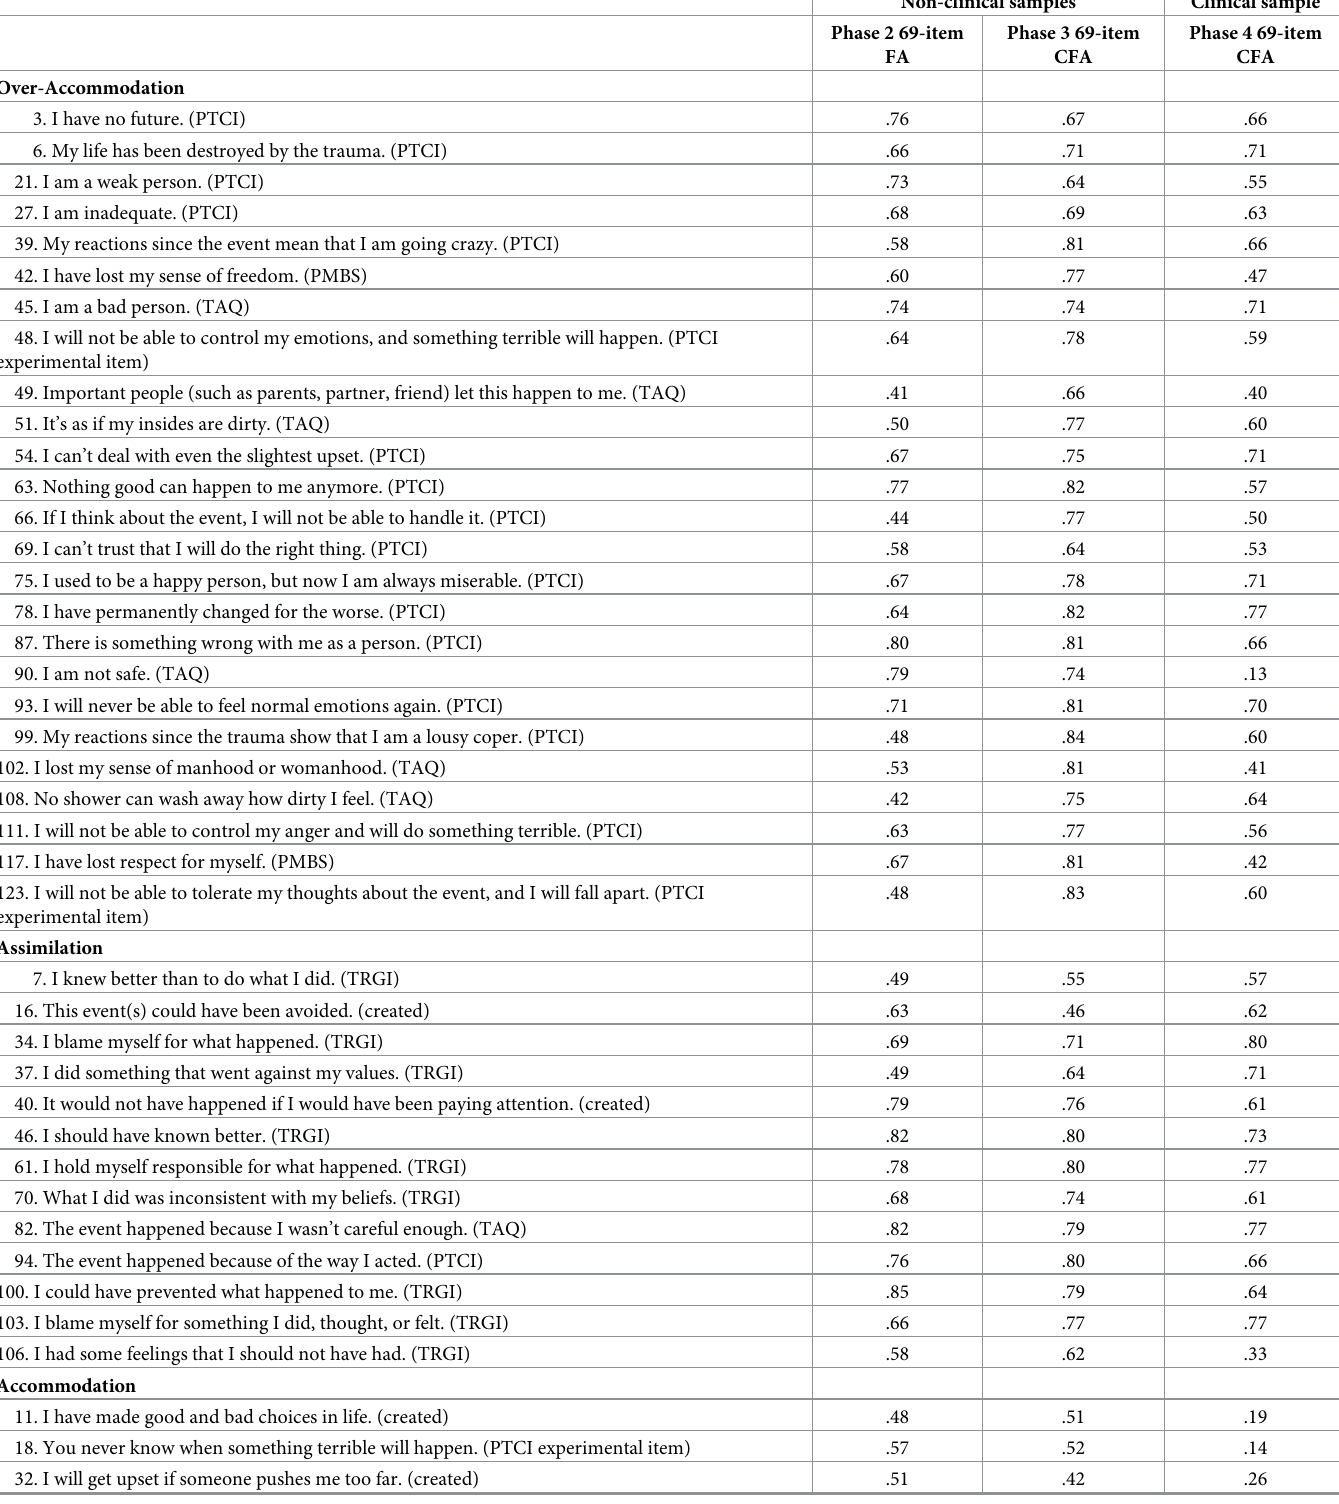
Table 2. Standardized factor loadings from EFA and CFA models fit to non-clinical and clinical